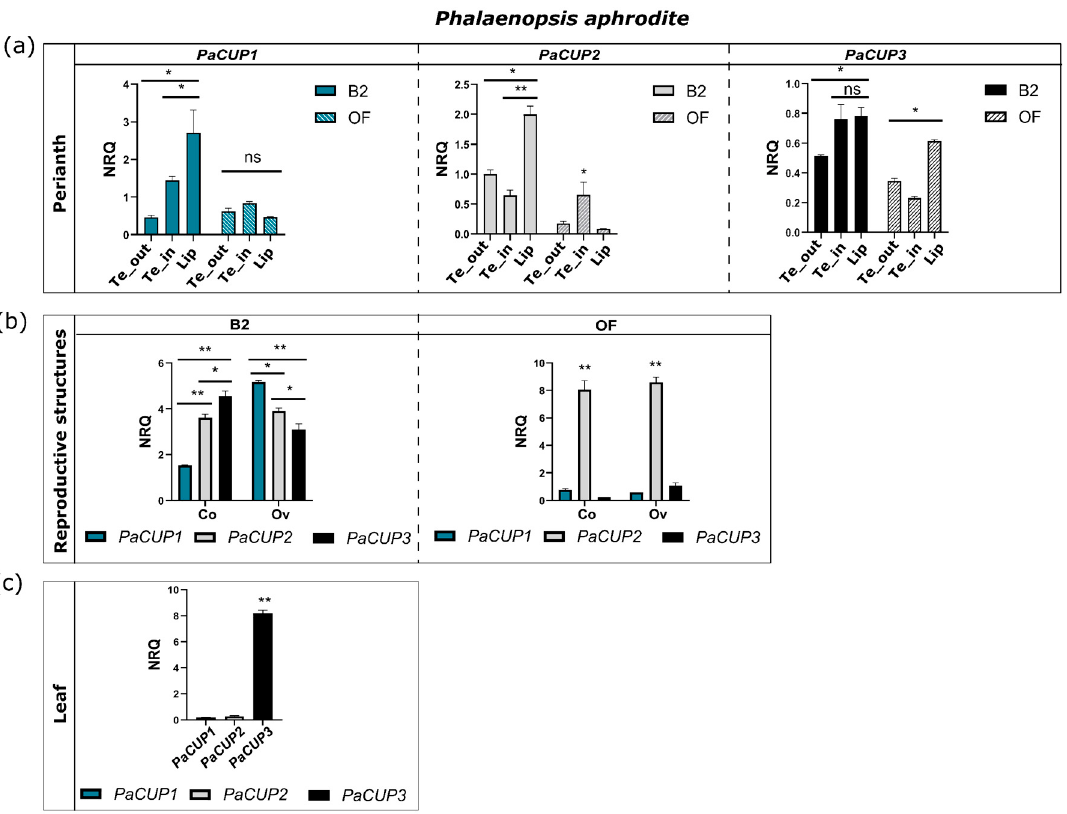
Figure 5. Expression patterns in P. aphrodite PaCUP genes. ( a ) perianth tissue; ( b ) reproductive tissue; ( c ) leaf. The expression level is reported as normalized relative quantity (NRQ) (reference gene 18S). The bars represent the SEM of the biological and technical replicates. The asterisks indicate statistically significant differences in the expression level at the B2 (early) and OF (late) stages. p values * <0.0004, ** <0.0001; ns, not significant. All the results are reported in Supplementary Data S4. Te_out, outer tepals; Te_in, inner tepals; Co, column; Ov, ovary.